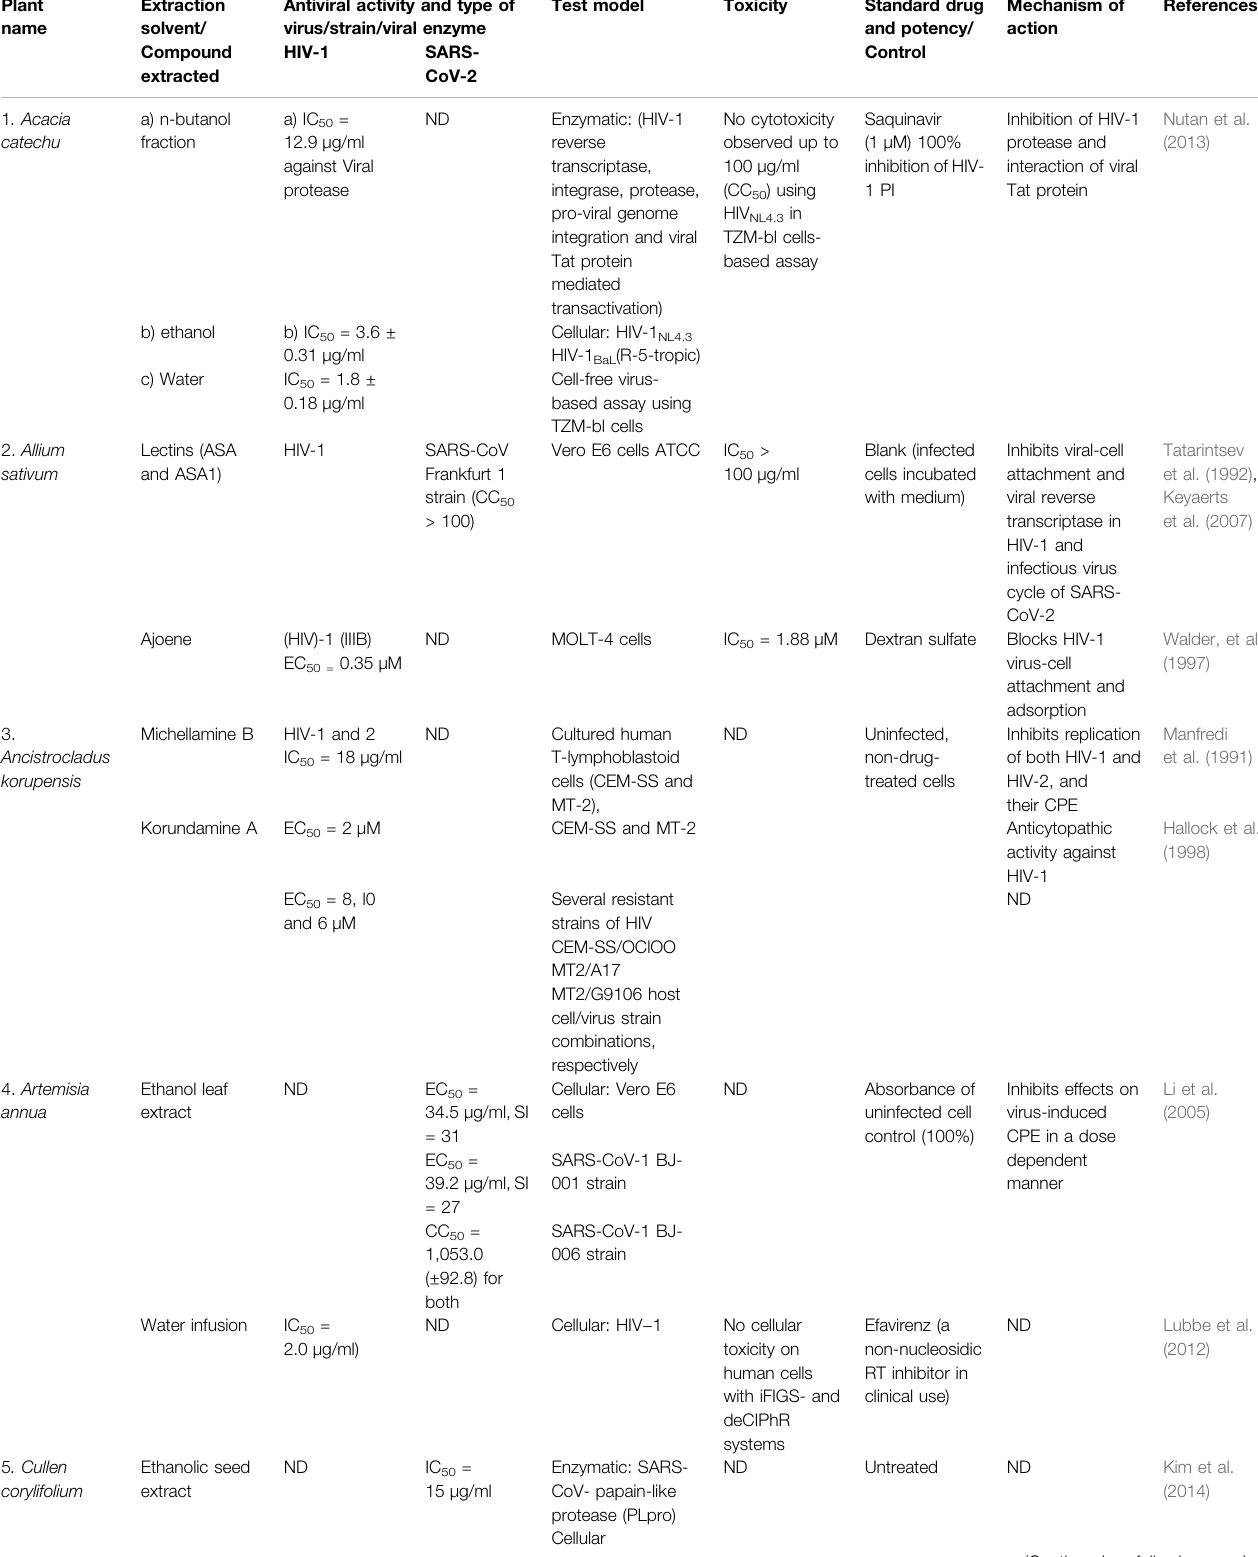
TABLE 1 | Medicinal plant species with HIV-1 and SARS-CoV-2 activities. Plant